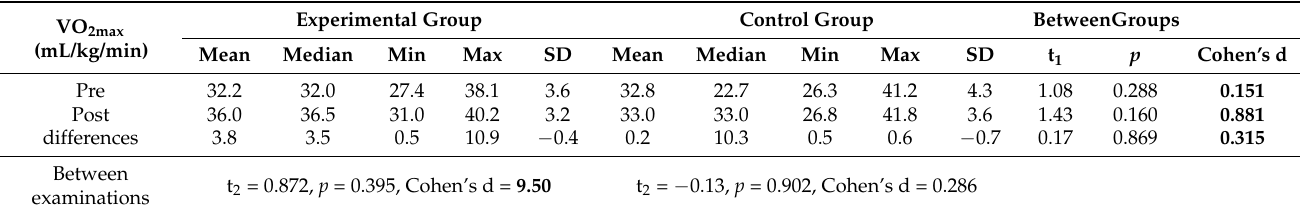
Table 6. Changes in the VO 2 values in the exercising and nonexercising groups following an 8-week period. VO 2max (mL/kg/min)